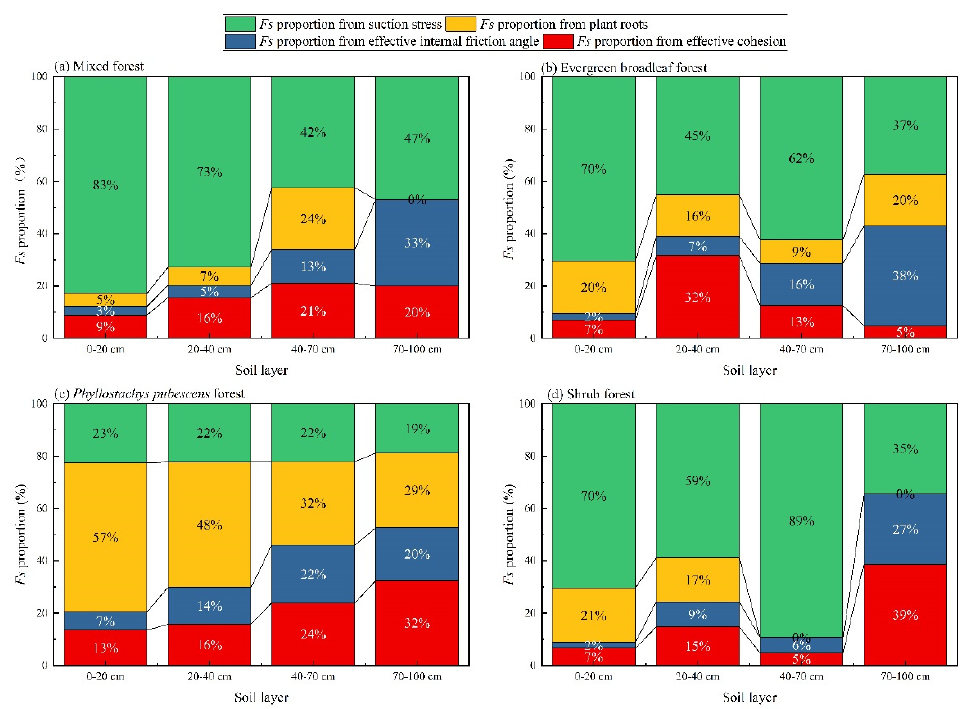
Figure 7. Contribution percentage of each influencing factor to hillslope safety factors at different soil depths in ( a ) mixed forest, ( b ) evergreen broadleaf forest, ( c ) Phyllostachys pubescens forest and ( d ) shrub forest.